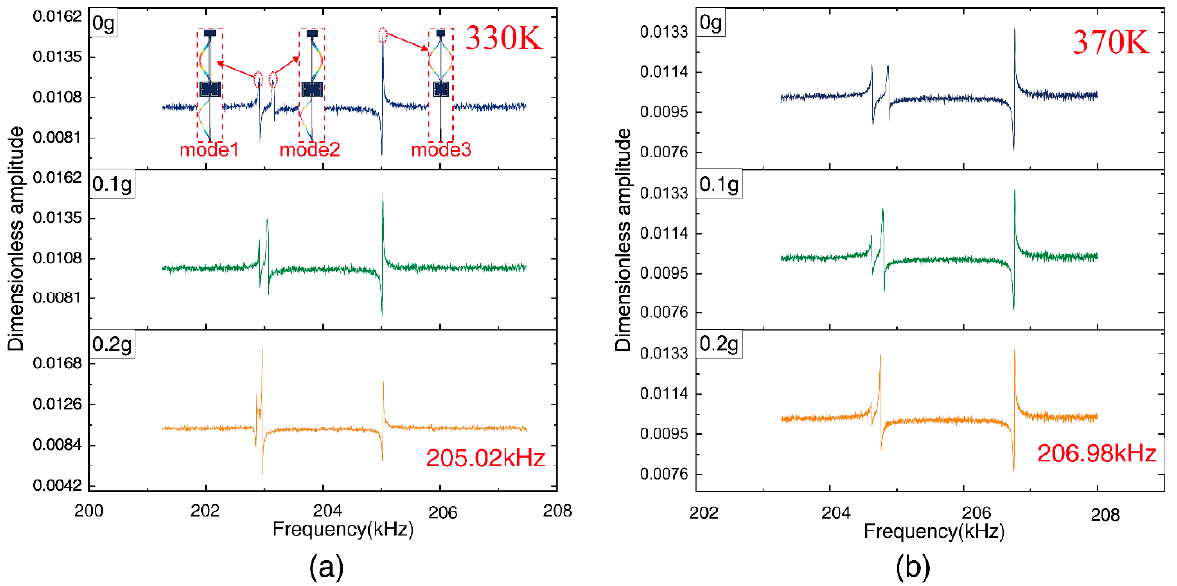
Figure 11. Amplitude–frequency response of the mode-localized accelerometer of 330 K ( a ) and 370 K ( b ) with different accelerations (0 g–0.2 g).